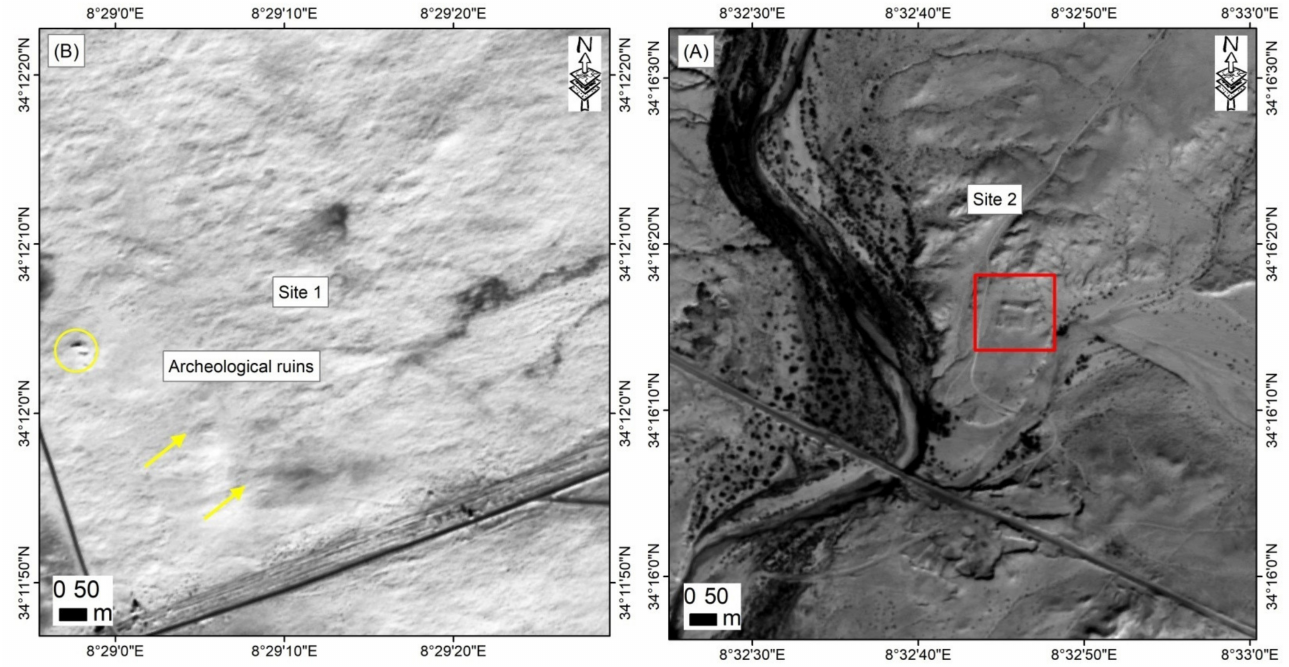
Figure 9. Results obtained from pansharpened Ziyuan-3-based PAN image data of sites 1 and 2, acquired on 9 July 2018, at a resolution of 2.1 m; the yellow polygons in the left part mark features of anomaly 1 ( B ), and the red box highlights anomaly 2 in the right part ( A